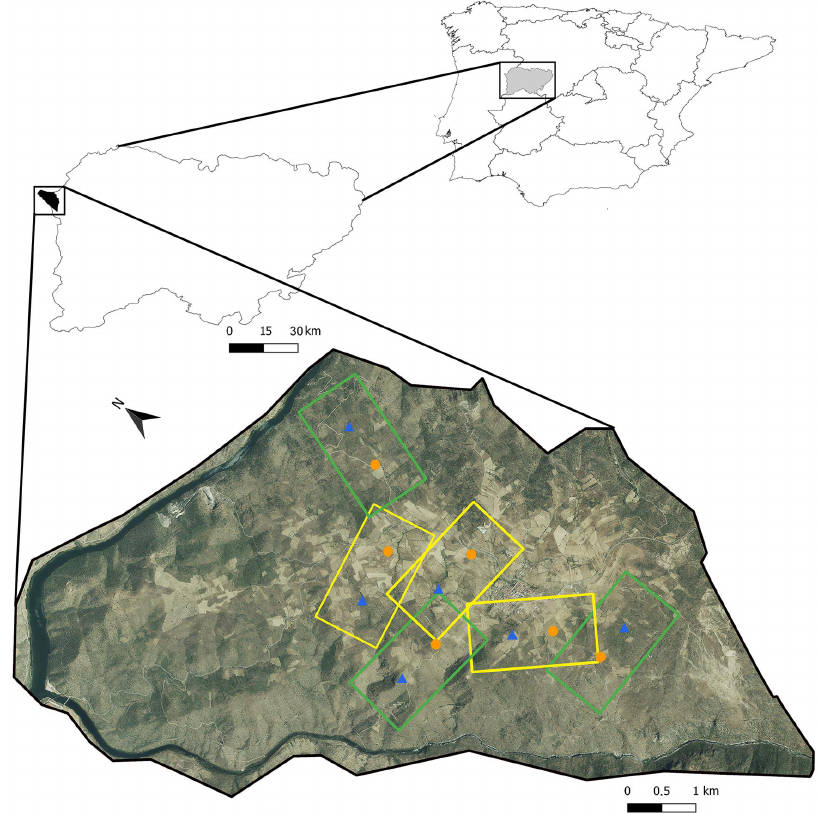
Figure 1. Location of the study area in the Salamanca province (Western Spain) and the placement of the 6 landscape windows (yellow: low level of semi-natural habitats, green: high level of semi- natural habitats) and 12 almond orchards (blue triangles: abandoned almond orchards, orange cir- cles: traditional almond orchards).